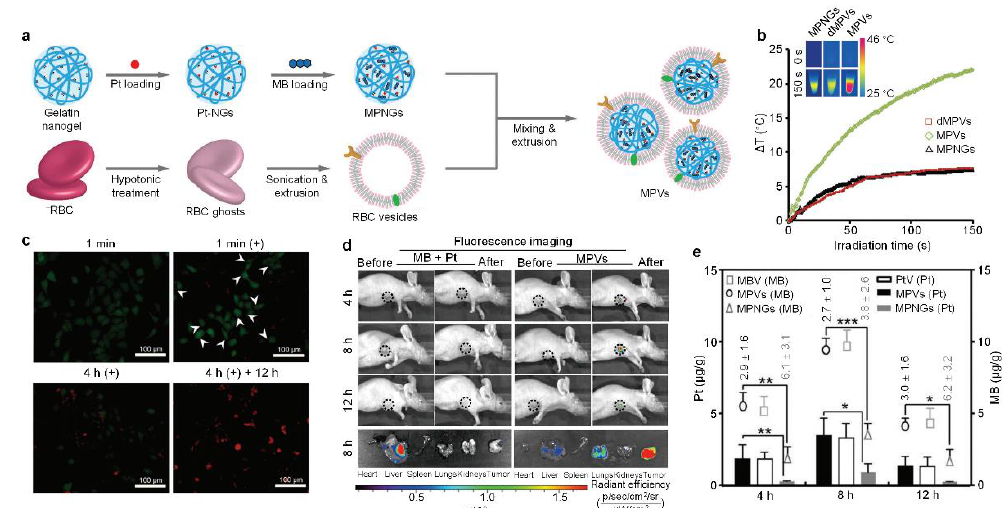
Figure 10. ( a ) Schematic illustration of preparation of red blood cell membrane-coated nanogels. ( b ) photothermal effect of pre-irradiated membrane-coated nanogels (dMPVs), MPVs and MPNGs under laser irradiation. ( c ) Fluorescence images of 4T1 cells incubated with MPVs for different times with or without laser irradiation. ( d ) Representative fluorescence images of MPVs- and free drugs-injected mice before and after laser irradiation at different time points. ( e ) Intratumoral concentrations of MB and Pt from tumor bearing mice treated with MBVs, PtVs, MPNGs, or MPVs for 4, 8, and 12 h. * p < 0.05; ** p < 0.01; *** p < 0.001. Adapted from [65]. Copyright © 2018 WILEY-VCH Verlag GmbH & Co. KGaA,